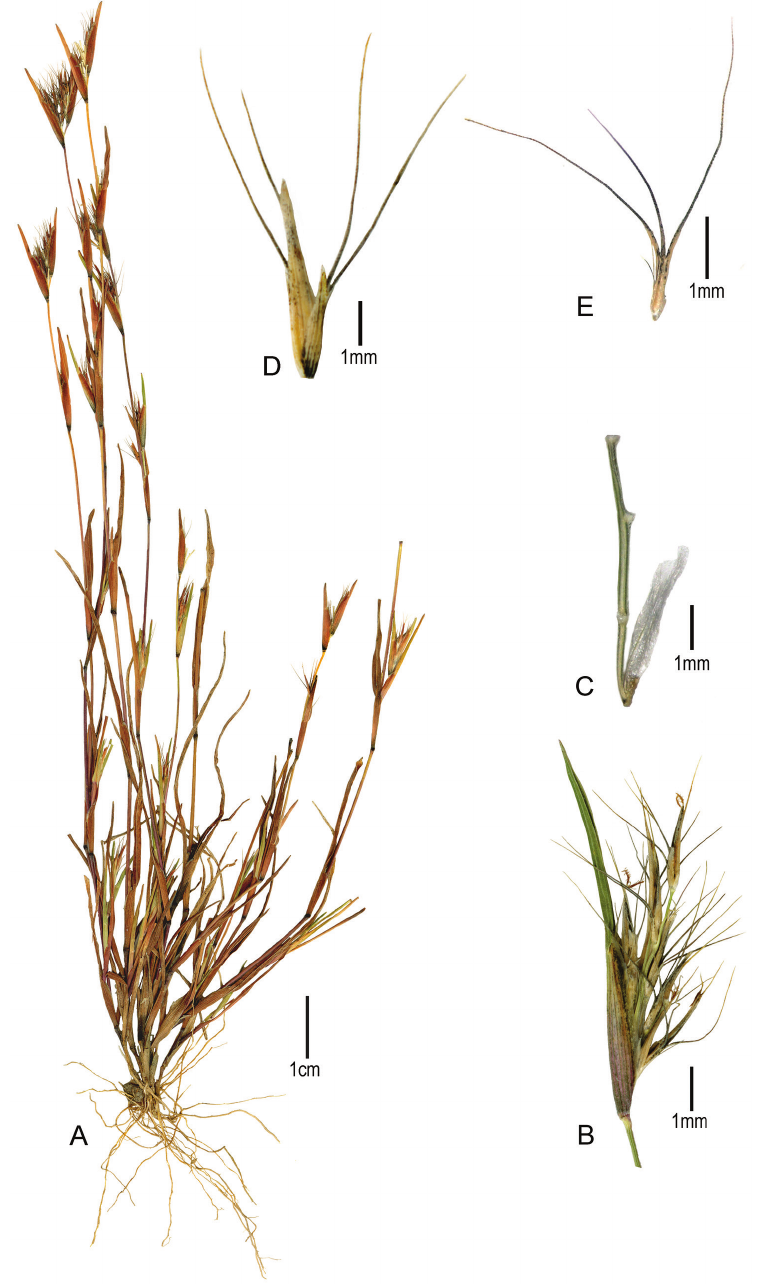
Figure 2. Muhlenbergia spatha : A Habit B Panicle partially enclosed by the leaf sheath C Basal panicle branch with a lower sterile floret and small cuplike structures (callus remains) where the fertile spikelets were inserted D Spikelet, side view E Upper glume showing three recurved awns, dorsal view. ( Peterson 25544 & Herrera Arrieta ,